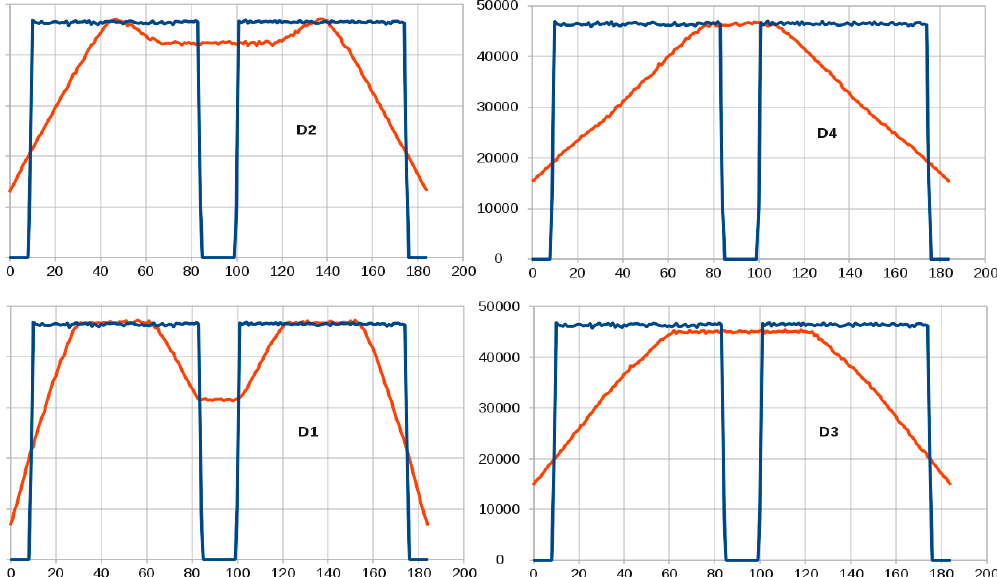
Figure 17. Computer simulations showing radiation profiles collected at detectors D1, D2 (before P1 hole), D3 and D4 (after P1 hole). Blue indicates parallel rays, red non-parallel, equally distributed rays. Non-parallel rays were generated according to Equations (3) and (4). The vertical axis represents the simulated radiation flux (resulting from 10 9 input rays). The horizontal axis represents the horizontal radial distance (with the central hole in the middle).